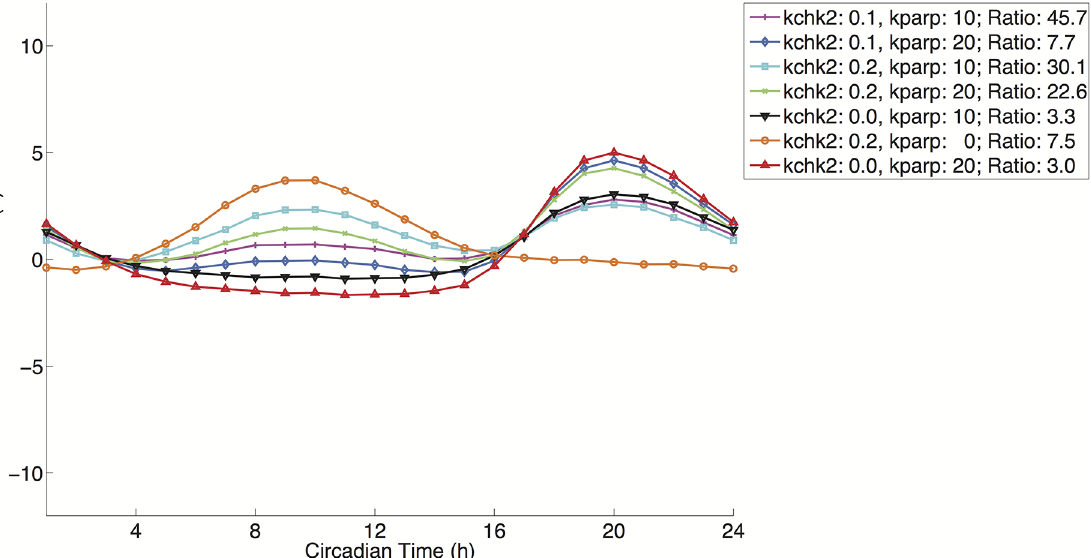
Fig 10. PRCs for various parameter combinations of kchk2 and kparp. Magenta/Plus: Advance to Delay Ratio: 45.7412; Light Blue/Diamond: Ratio: 7.6848; Cyan/Square: Ratio: 30.1066; Green/X-Mark: 22.6498; Black/Down Triangle: Ratio: 3.3353; Orange/Circle: Ratio: 7.5161; Red/Up Triangle: Ratio: 3.007. Details on parameter values used are found in Table